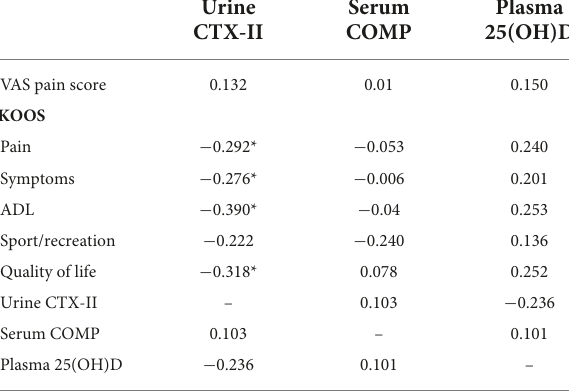
TABLE 5 Mean ± SD in plasma and red blood cell (RBC) of eicosapentaenoic acid (EPA), docosahexaenoic acid (DHA) and total n -3 long chain-polyunsaturated fatty acids ( n -3 LC-PUFA) at baseline, end of study and change from